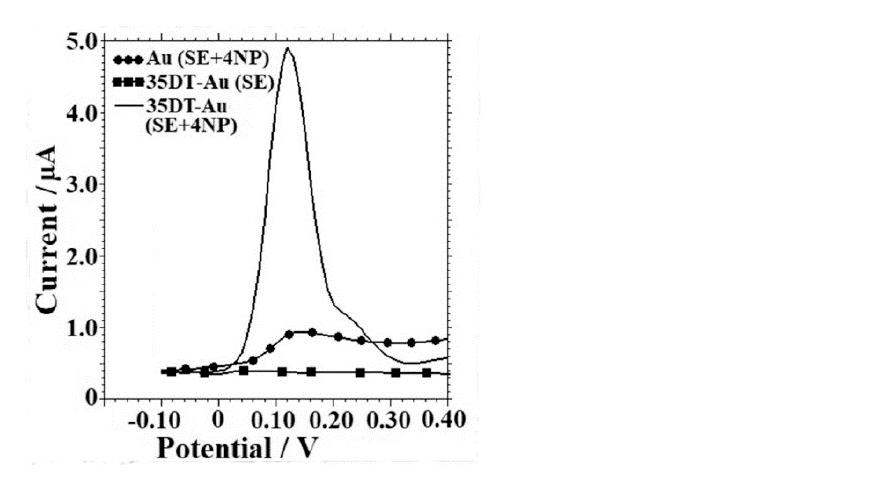
Figure 25. Differential pulse voltammetry of poly (35DT)/Au electrode without 4-nitrophenol (solid square line), a bare gold electrode with 50 mM of 4-nitrophenol (solid circle line), and poly (35DT)/Au electrode with 50 µM of 4-nitrophenol (solid line). Modified with permission from [298]. Copyright 2019 Wiley-VCH Verlag GmbbH and Co.